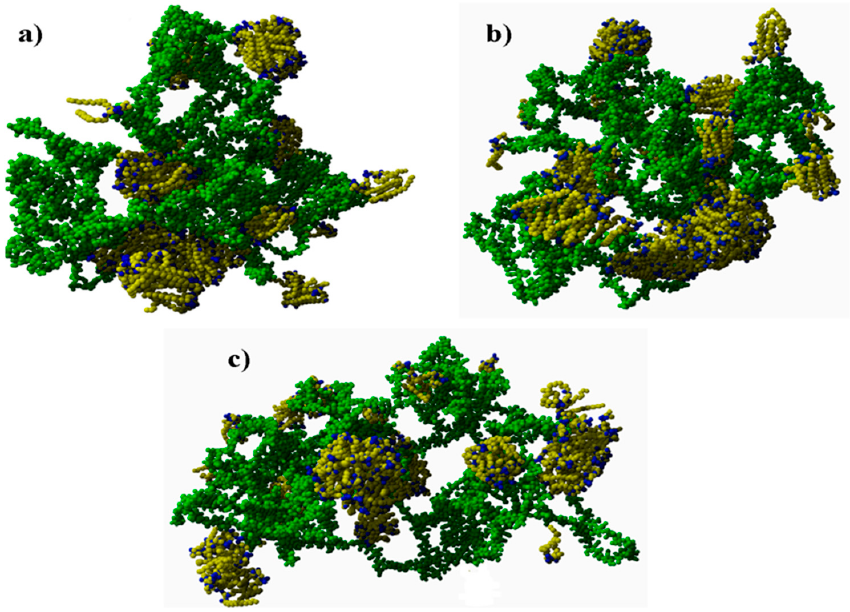
Figure 3. Final structures obtained from the simulation for different (A-) molecular masses (MM). From left to right the (A-) molecular mass increases. Hydrophilic parts of PL are depicted as blue, whereas their hydrophobic counterparts—yellow. (A-) is depicted as green for better visualization of PL orientation towards the (A-) network. Structures show three cases for MM of hyaluronan: ( a ) short 10 kDa; ( b ) mid 40 kDa; and ( c ) long 160 kDa.